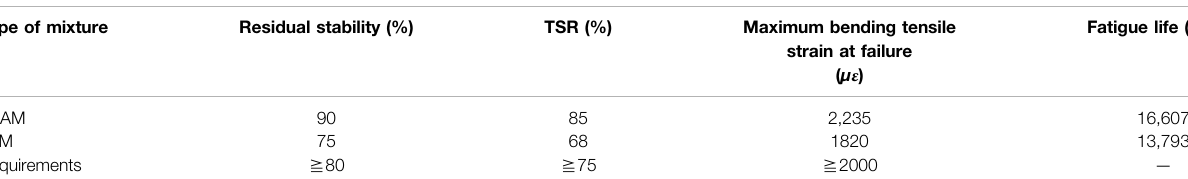
TABLE 5 | Experimental data of water stability and low-temperature deformation performance. Type of mixture